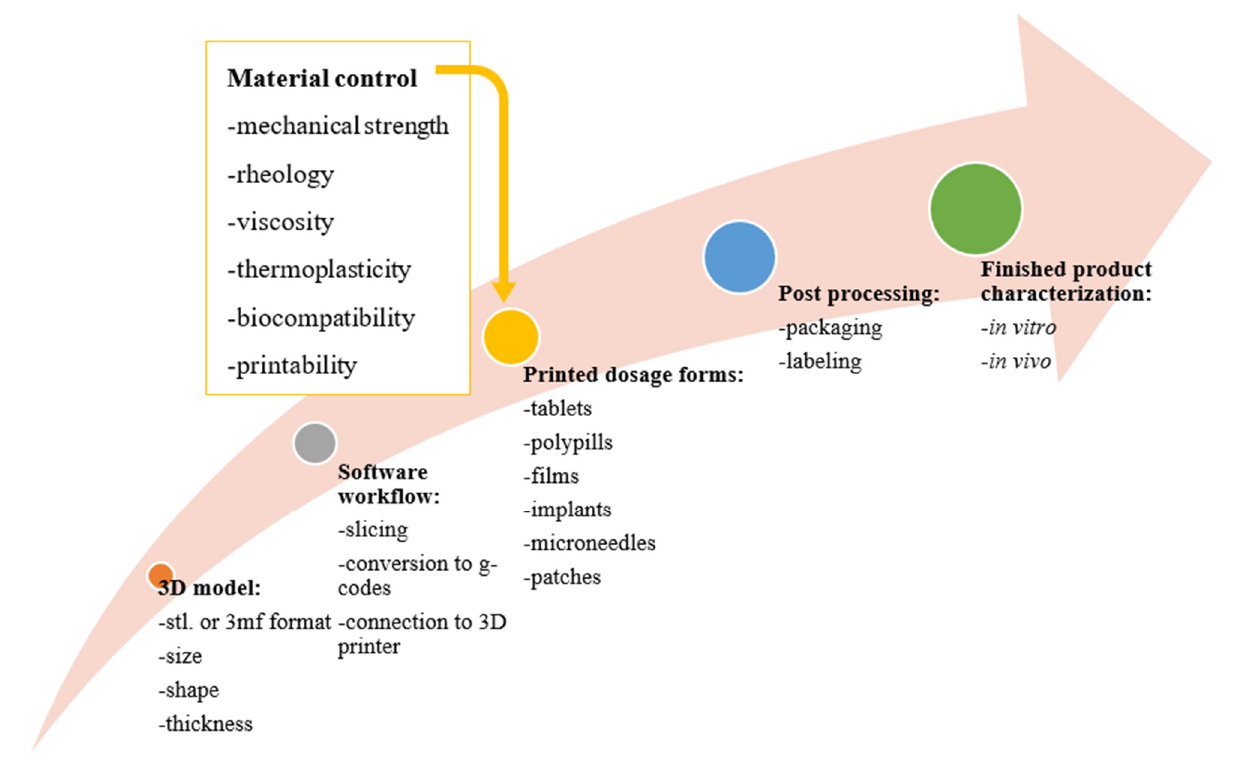
Figure 1. Schematic illustration of the additive manufacturing process for pharmaceutical products, Reproduced from [25], IntechOpen, 2021.